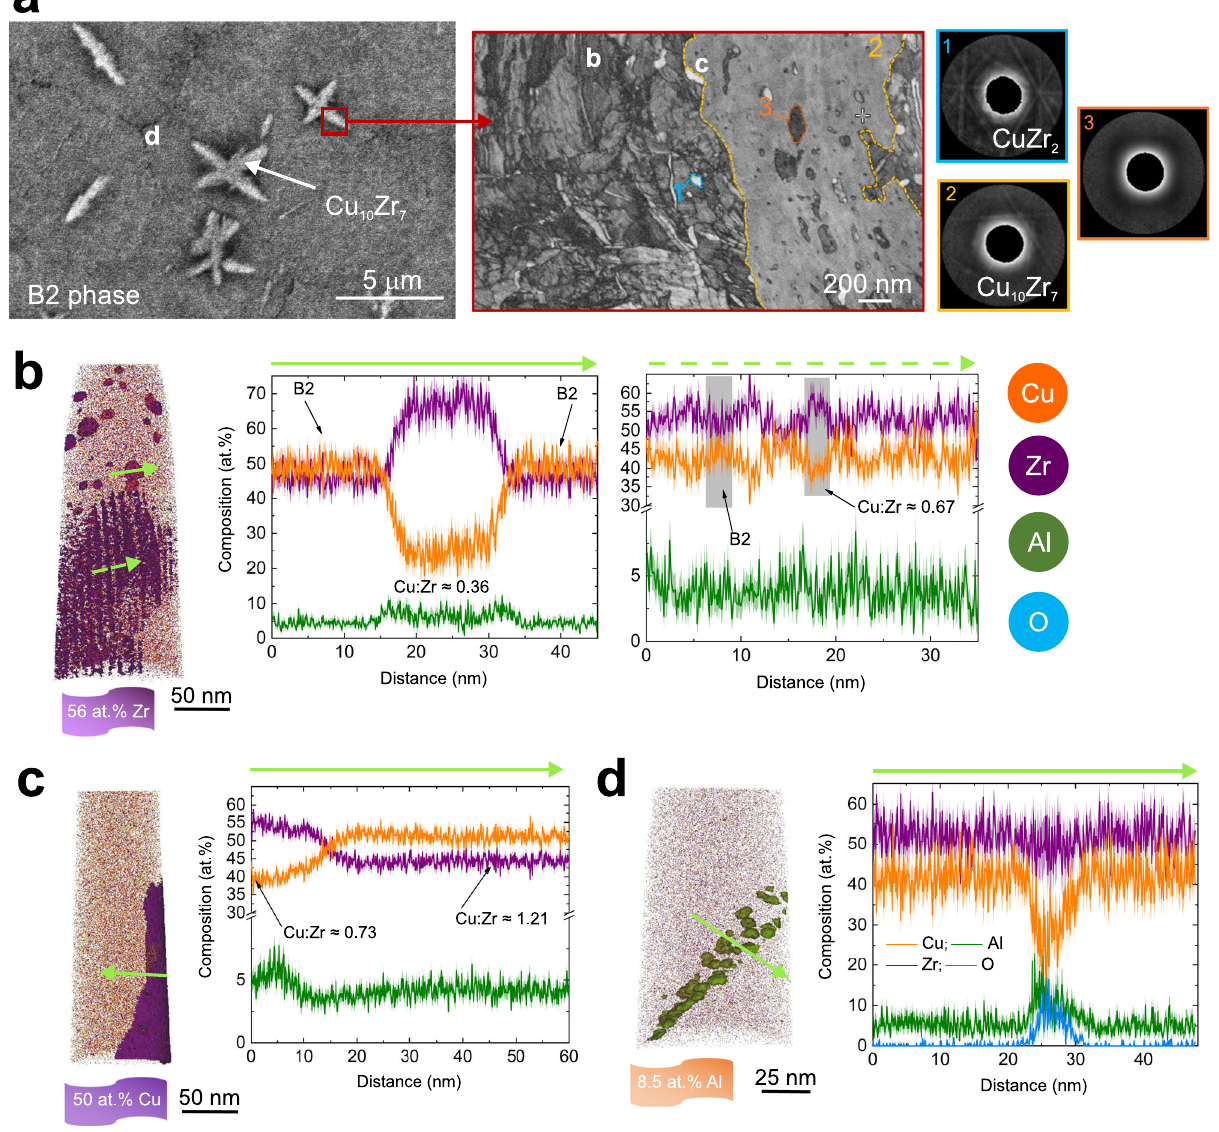
Fig. 7 Atom probe tomography reconstructions of the local microstructure after fl ash-annealing at a supercritical-heating rate as shown in Fig. 2. a Left: SEM micrograph of an area from which APT samples were extracted. Middle: Transmission Kikuchi diffraction image quality map showing details of the interface between Cu 10 Zr 7 (the region enclosed by the yellow borderline) and B2 phases (uncolored); the latter contains CuZr 2 phase (the region enclosed by the blue borderline). Right: Individual Kikuchi patterns taken from the mapping depicted in the middle (blue: CuZr 2 , yellow: Cu 10 Zr 7 , orange: amorphous). The letters in the left and the middle micrographs mark different regions where the APT samples illustrated in b – d were extracted from. b 3-D atom map showing precipitates within the B2 matrix and a local eutectoid microstructure consisting of linear features arranged as a plane with the corresponding 1-D concentration pro fi les. c 3-D atom map of a region dominated by Cu 10 Zr 7 phases is shown together with the corresponding 1-D concentration pro fi le. d Aluminum precipitation within the B2 crystal and the corresponding 1-D concentration pro fi A representative SEM micrograph of a polycrystalline sample